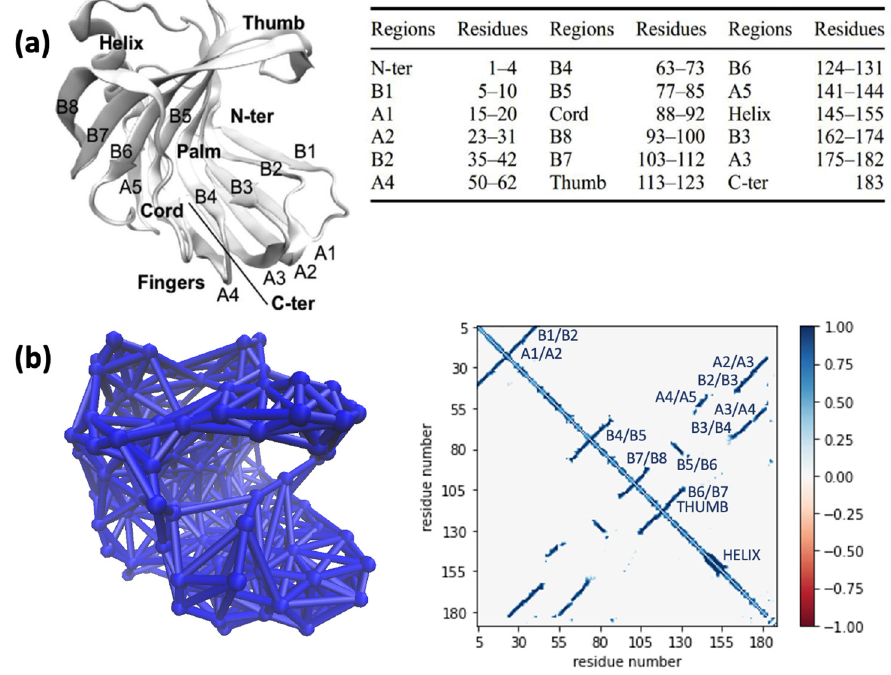
Figure 2. ( a ) The map of local segments with defined secondary structures according to the residue numbers. Beta strands within the Finger regions were named by AX, while those within the Palm regions were named by BX. ( b ) ( Left )—a residue interaction network (RIN) representation of the wildtype xyn11A in this study, and ( Right )—adjacency matrix defining edges of the RIN by the 7.4 Å distance cutoff between pairs of C-alpha atoms. Regions of non-zero off diagonal elements were labelled as the connection between beta strands within the beta sheet and the ‘Thumb’ regions.